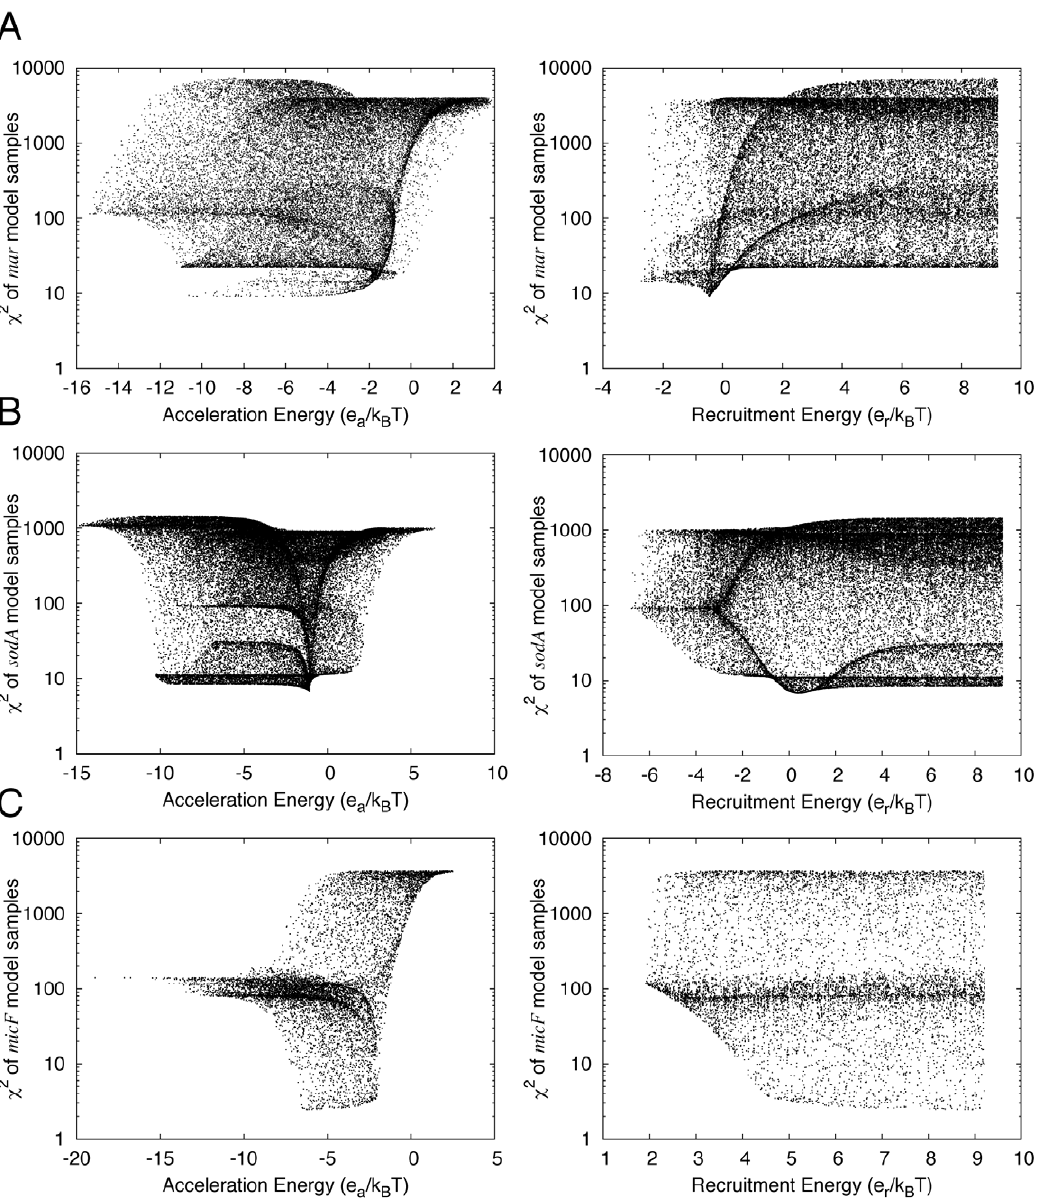
Figure 3. Dependence of x 2 of promoter activity models on the acceleration energy and recruitment energy. A) marRAB ; B) sodA ; C) micF . The value of x 2 is plotted on the y -axis in all panels. The left panels plot acceleration energy ( e a ) and right panels plot recruitment energy ( e r ) on the x -axis. Points correspond to 10,000 different sets of parameter values, sampled using the nominal values in Table 1. Points with the lowest x 2 value correspond to the systems in Table